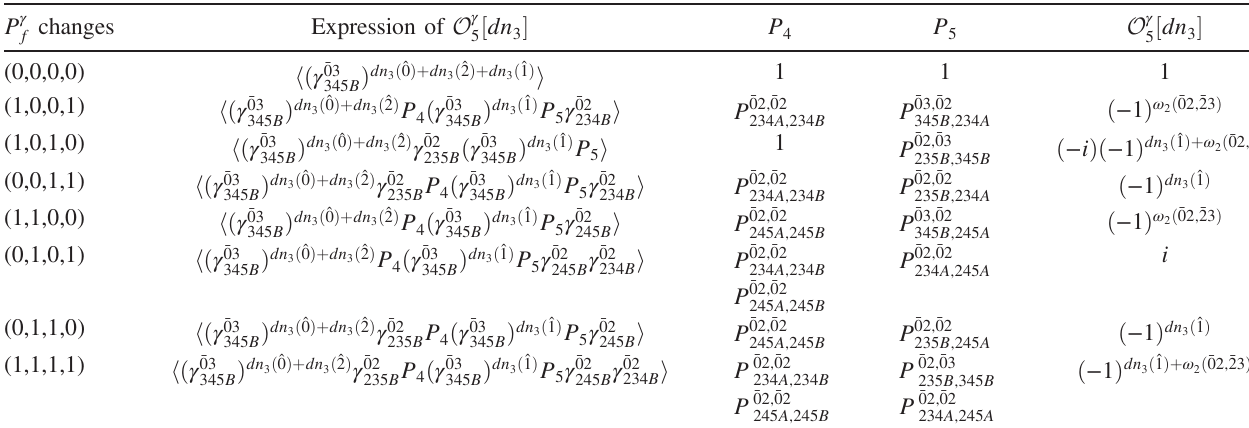
TABLE V. Calculations of O γ 5 ½ dn 3 (cid:2) for all possible Kitaev chain configurations in the superhexagon equation shown in Figs. 11 and 12. The first column is the Majorana fermion parity change quadruple ½ dn 3 ð There are in total eight different cases. The second column is a simplified version of Eq. (225). The third and fourth columns are the Majorana pairing projection operators we use in the calculation. The last column is the final result of O γ 5 ½ dn 3 (cid:2) , which can be summarized by Eq. (232).